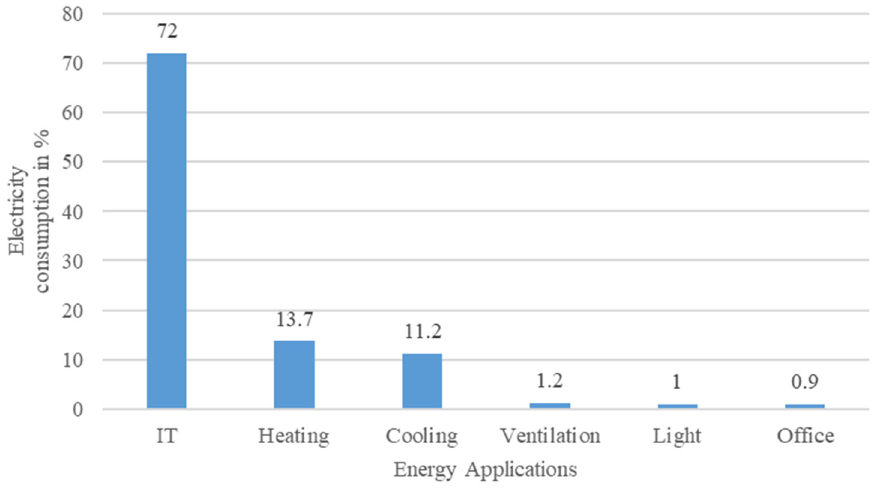
Figure 5. Distribution of the electricity consumption in data centers.